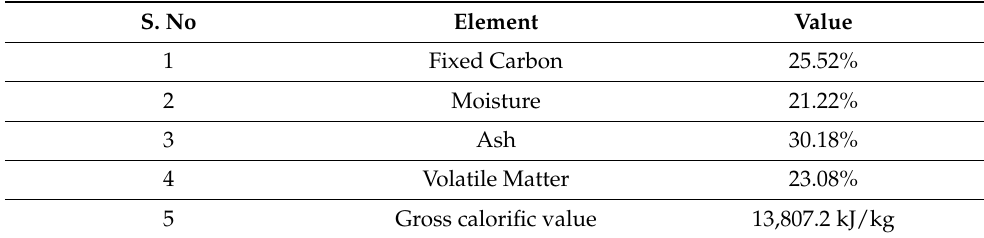
Table 2. Coal proximate